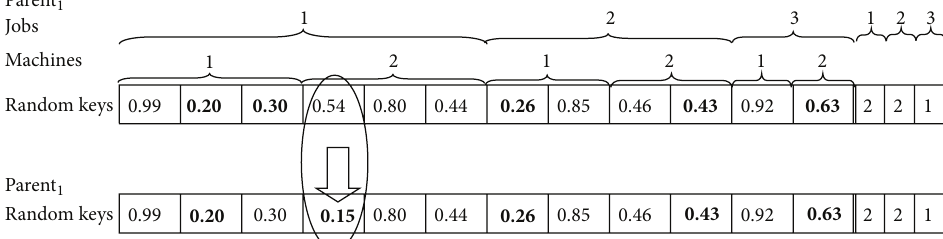
Figure 4: Mutation